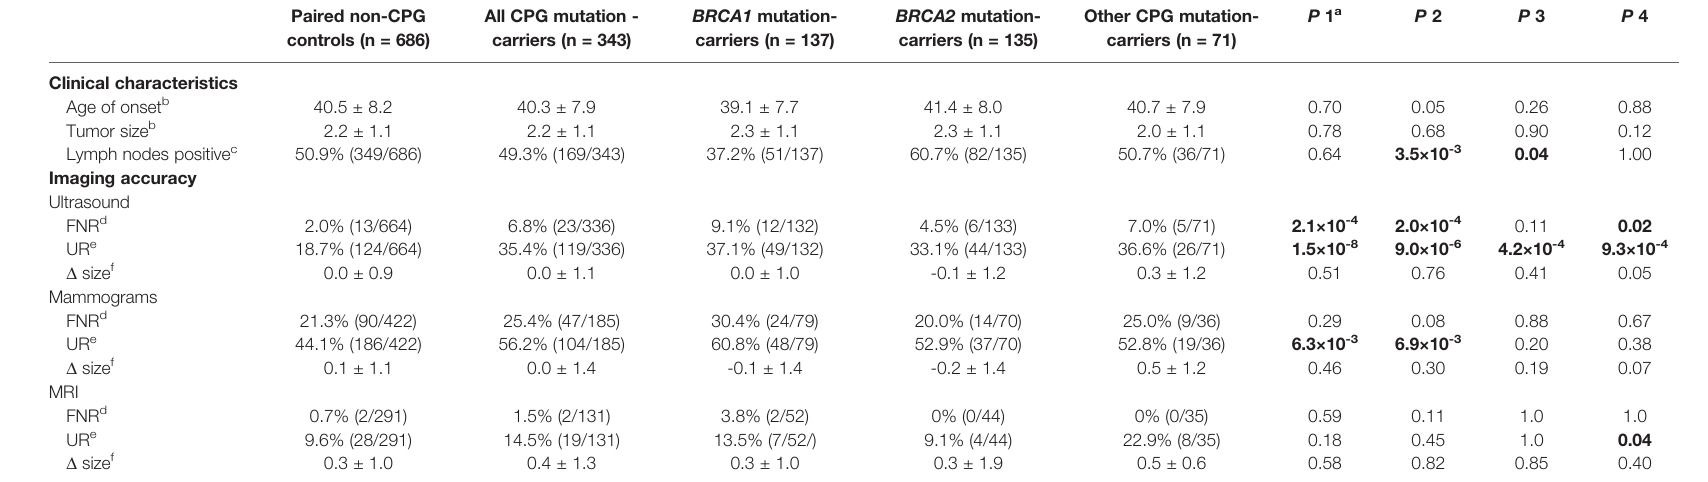
TABLE 2 | The performance of imaging modalities in patients with cancer predisposition gene mutations and pair non-mutation controls. Paired non-CPG All CPG mutation - controls (n = 686) carriers (n = 343) Clinical characteristics Age of onset